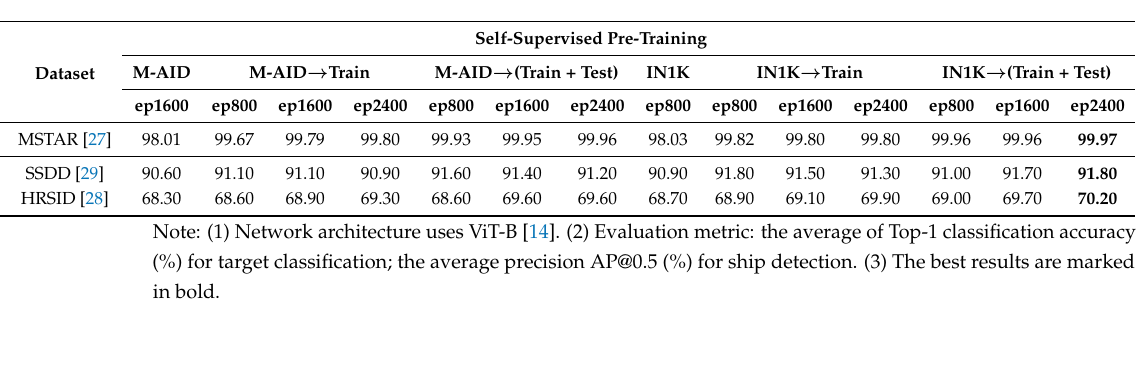
Table 4. The knowledge transfer ability comparison on SAR